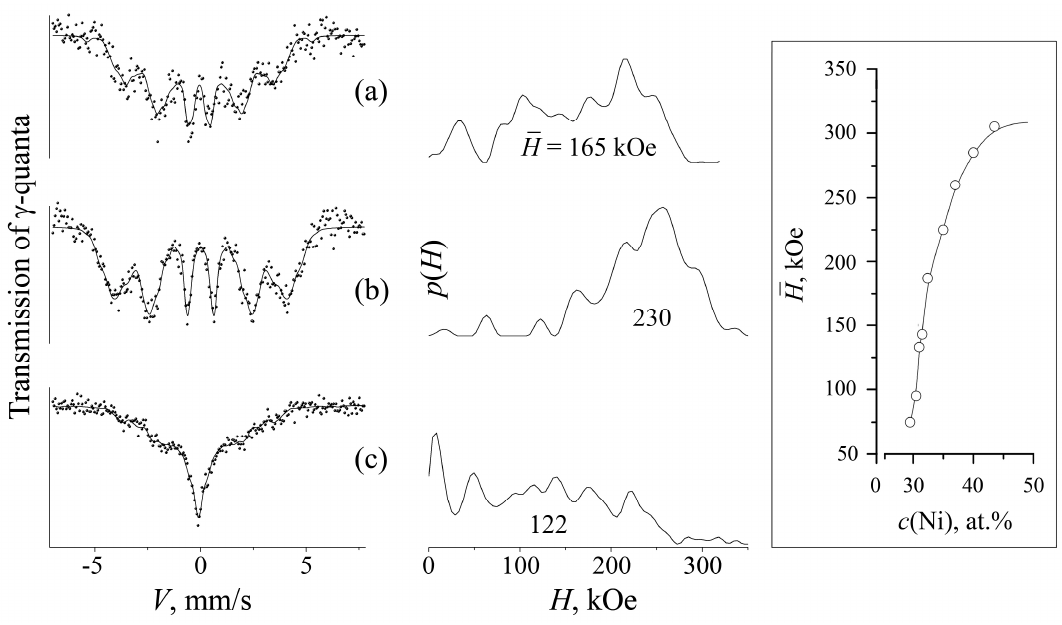
Figure 14. Spectra, the distributions p ( H ), and magnitudes of H for the alloy Fe 55 Ni 36 Al 9 . Treatment (state): ( a ) annealed at 873 K for 3 h (aged); ( b ) aged and HPT treated with ε = 3.9 (0.5 rev) at 80 K; ( c ) aged and HPT treated with ε = 3.9 (0.5 rev) at 573 K. In the inset we show the dependence H = f ( c (Ni)) for FCC binary Fe-Ni alloys borrowed from [46].